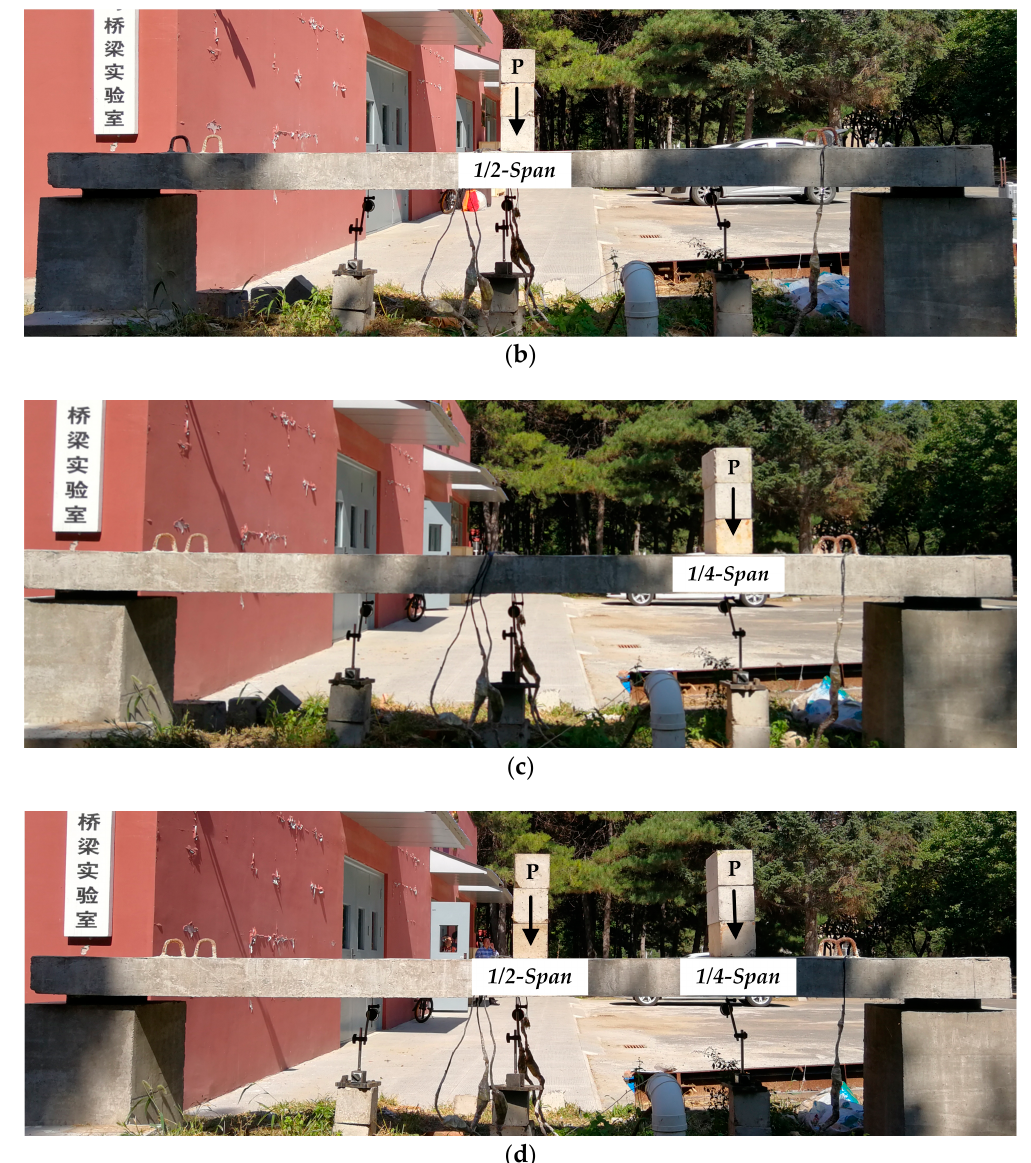
Figure 5. Static test configuration: ( a ) Static test equipment; ( b ) Case 1; ( c ) Case 2; and ( d ) Case 3. Table 1. Mixture proportions of slab